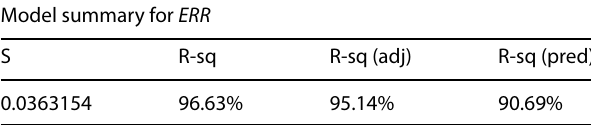
Table 15 Model summary for ERR Model summary for